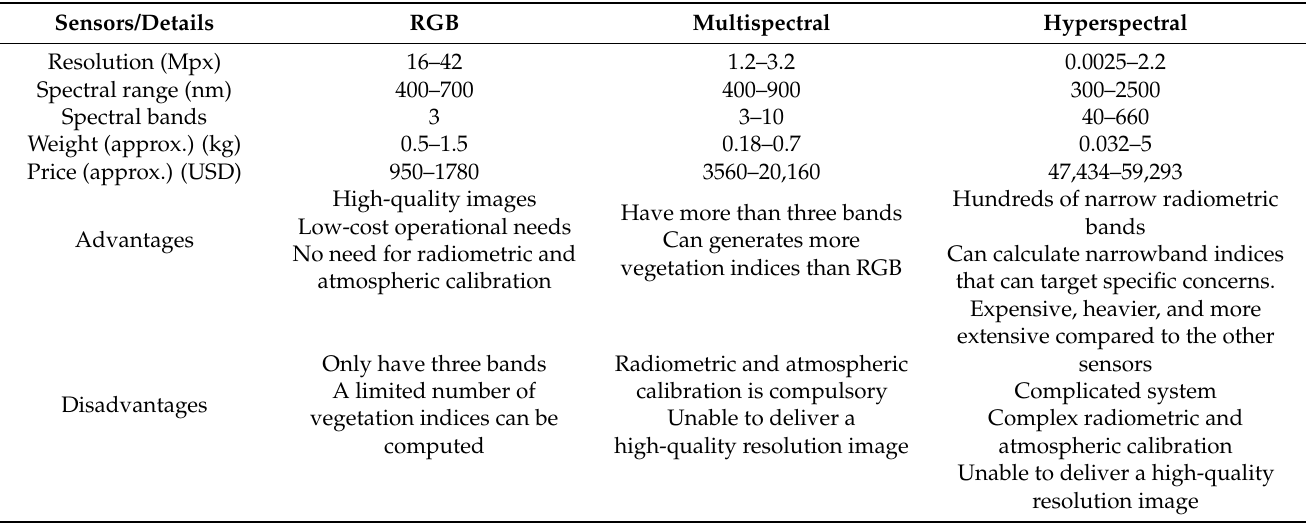
Table 2. Characteristic of RGB, multispectral, and hyperspectral